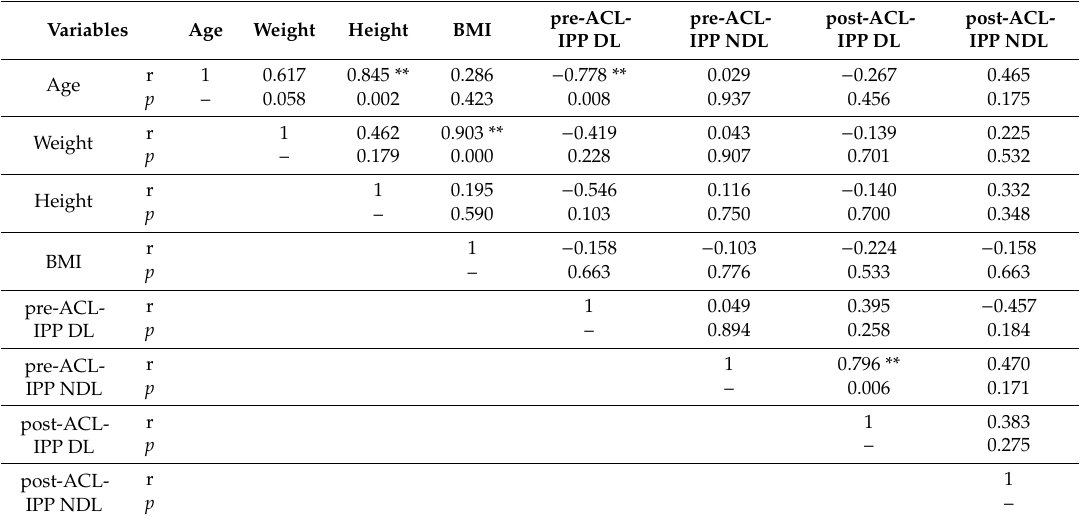
Table 2. Correlations among age / anthropometric variables and ACL-IPP in DL and NDL.